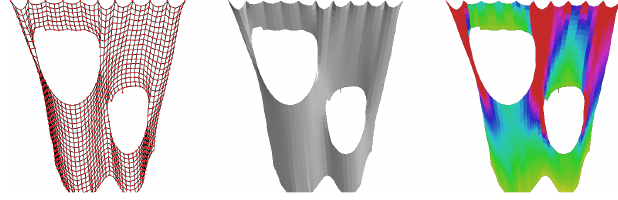
FIG. 1. A simple simulation of hanging cloth is visualized in three different ways. The left visualization shows the structure of the simulation, how the particles and springs are connected. The middle visualization shows the overall structure of the cloth and highlights larger deformations using the shading. The right visualization shows the magnitude of the forces each particle